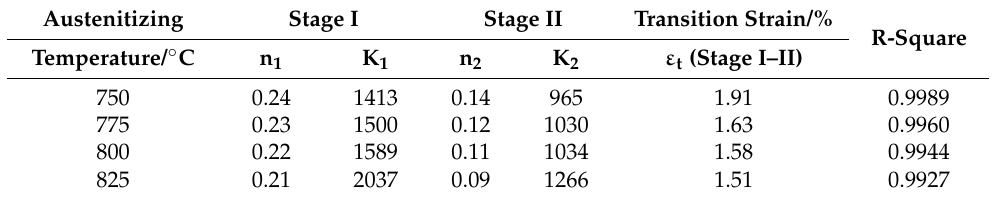
Figure 7. ( a ) The ln σ vs. ln ε plots for the Hollomon model of LH800 steel. The slope of the line segment is n ; ε t is the transition strain between each deformation stage. ( b ) Effect of austenitizing temperature on the work hardening behavior of each stage and the transition strain in the Hollomon model of LH800 steel. Table 2. Parameters related to the work-hardening behavior in the Hollomon model of LH800 steel.